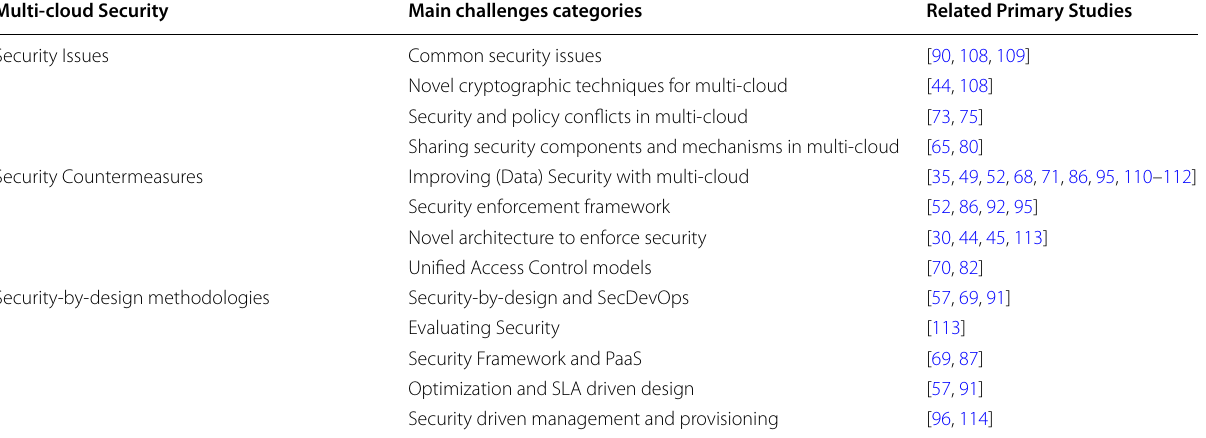
Table 9 Identified challenges in the Security of multi‑cloud applications Multi‑cloud